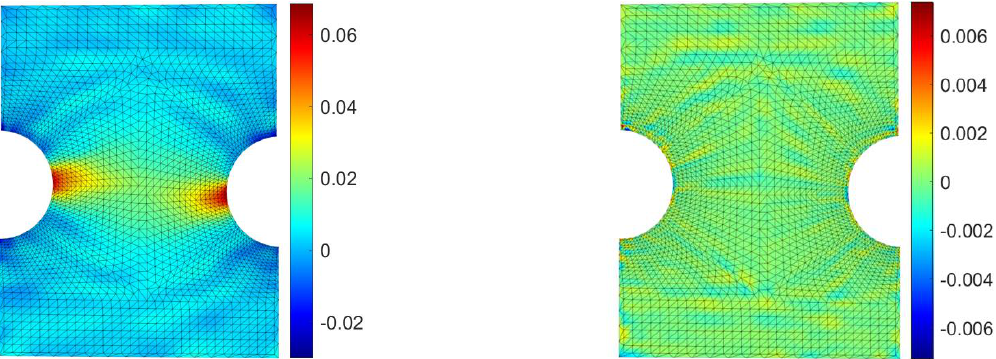
Figure 14. FEM contour map of the strain along the y direction for the aluminum specimen ( left ) and its difference with respect to the proposed method ( right ).